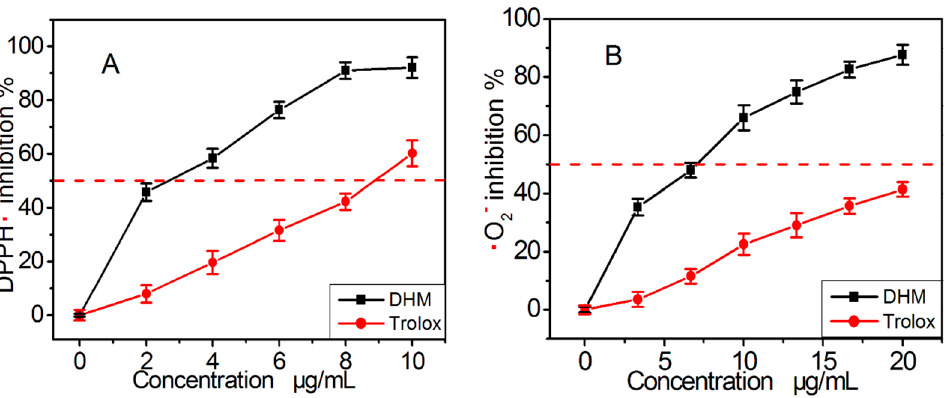
Figure 7. The dose response curves of dihydromyricetin (DHM) and the positive control Trolox in